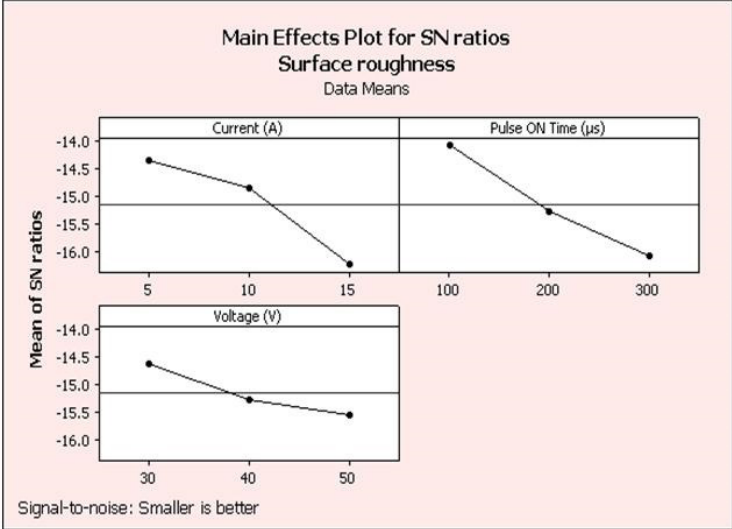
Figure 5. Main effects plot for SN ratios - SR-EDM.